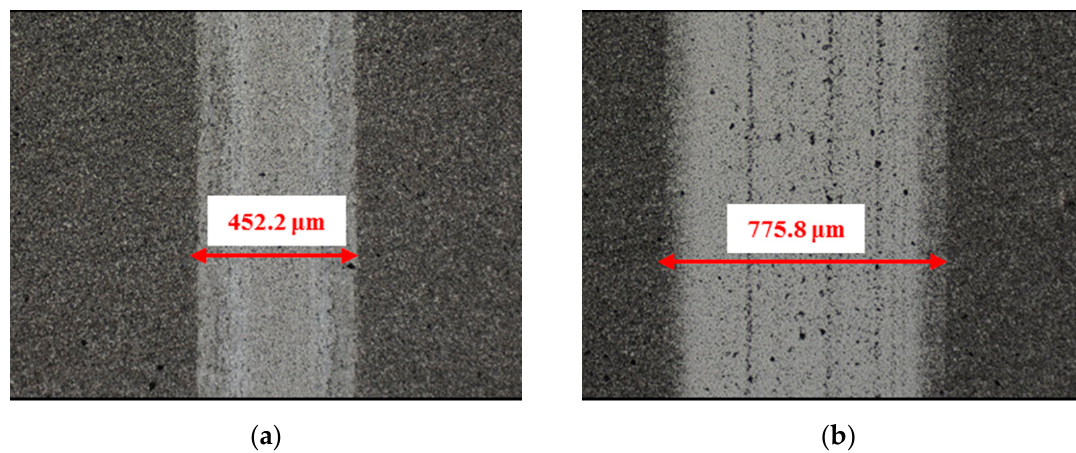
Figure 15. Wear performance of un-textured SiC under water-lubricated conditions with a load of 75 N (×10): ( a ) un-textured SiC–steel ball and ( b ) un-textured SiC–Si 3 N 4 ball.